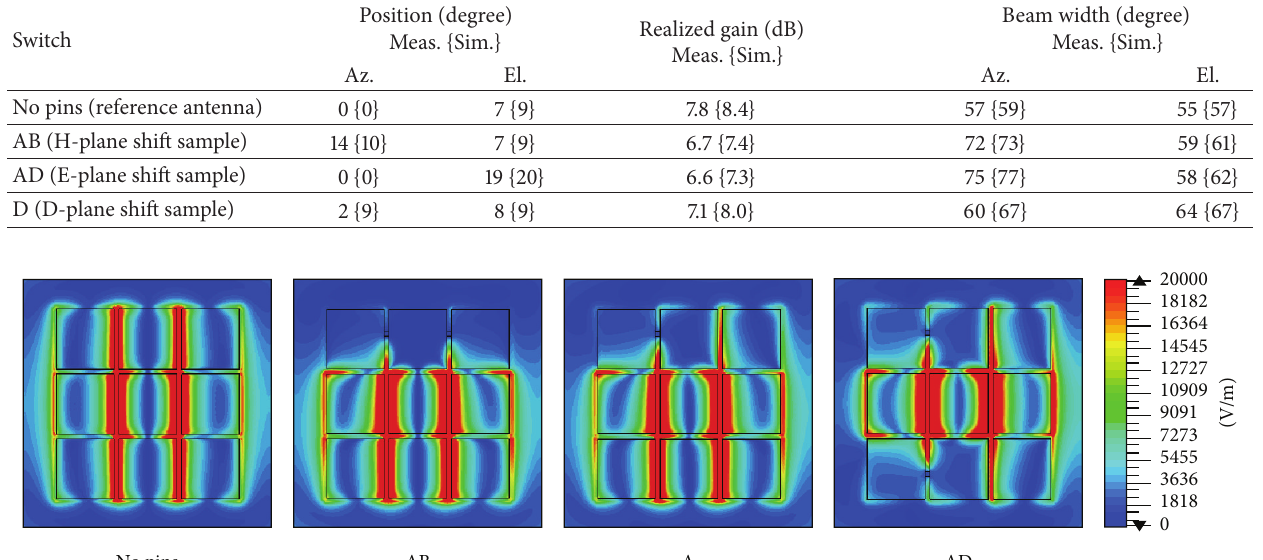
Table 3: Measured and simulated patterns parameters.